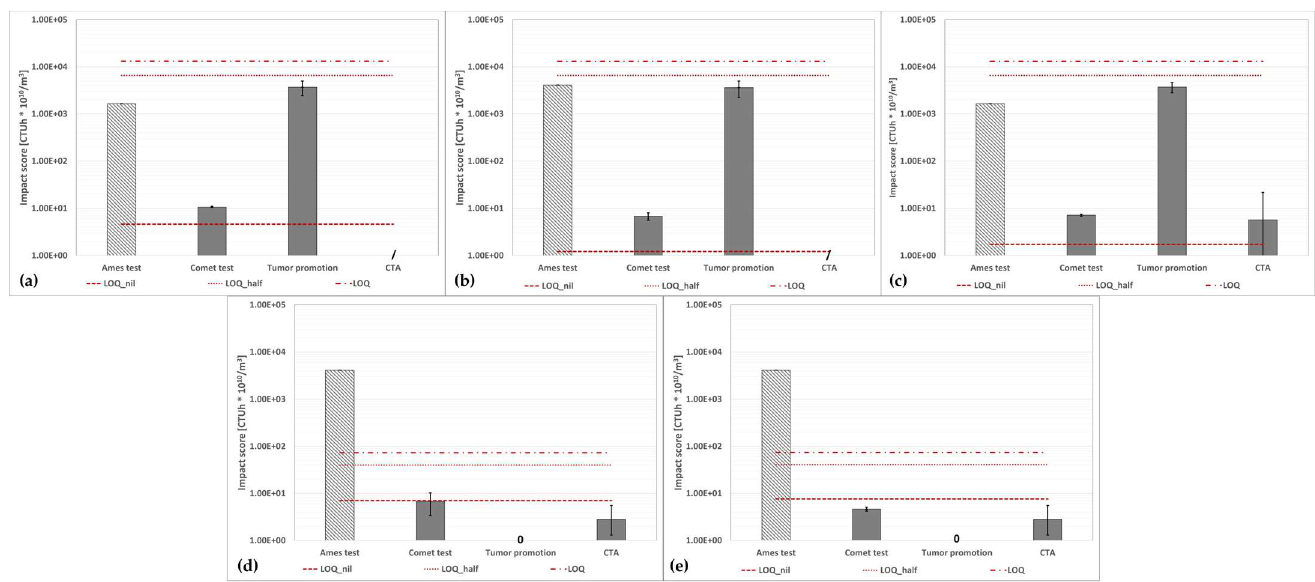
Figure 6. ( a ) WWTP A; ( b ) WWTP B, routine time; ( c ) WWTP B, harvest time; ( d ) WWTP C, CAS; ( e ) WWTP C, MBR: calculated environmental footprint using the alternative protocol for the human toxicity/cancer category (the three red dotted lines represent the conventional impact score calculated with the abovementioned three ways). The character “/” indicates that the assay was not performed. The Ames test histogram shows that the impact score is lower than the displayed value.